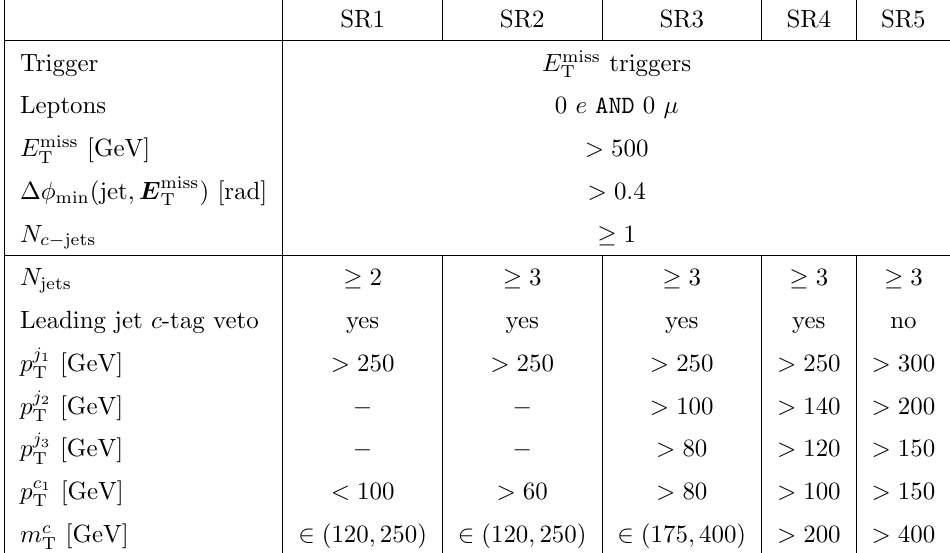
, p j 2 and p j 3 indicate the transverse momentum of the T T T is the transverse momentum of the c -jet with T